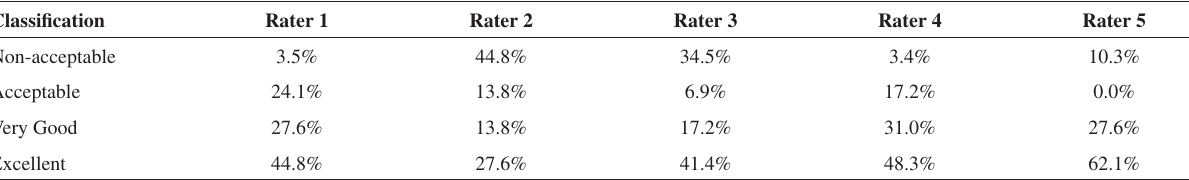
Table 3 - Intra-rater reliability: results for individual